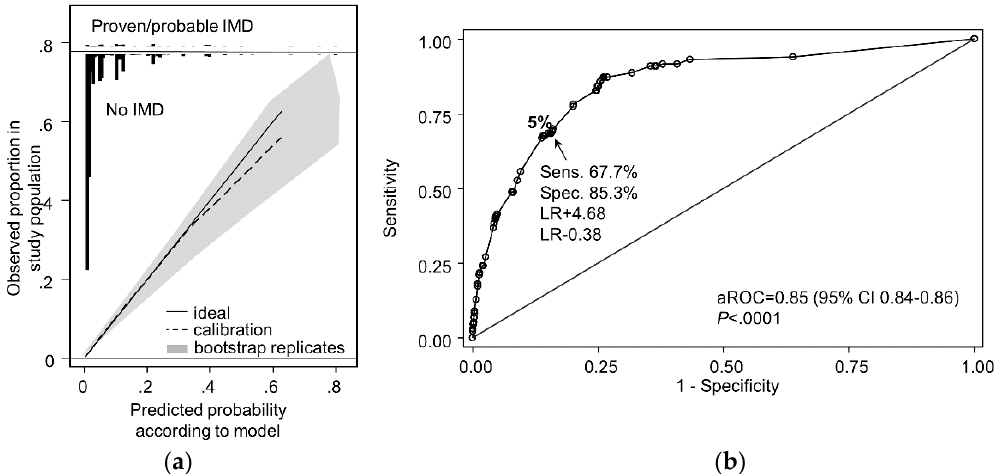
Figure 4. Revised BOSCORE model calibration and discrimination. Panel ( a ) shows the relationship between a perfectly calibrated model (solid line) and the observed incidence of EORTC/MSG proven, or probable mold disease fitted using the Loess smoothing algorithm (dashed line). Black bars on the top frame of the graph show the relative risk distribution of admissions without IMD (downward pointing spikes) or patients with proven or probable IMD (upward pointing spikes). The gray shaded area shows observed versus predicted incidence of proven or probable mold disease in 100 bootstrapped resampled datasets with varying IMD incidence of 2–9%. Panel ( b ) shows the area under the receiver operator curve (aROC) and predicted performance for EORTC/MSG probable or proven IMD at a prediction cut-off of 5%. Sens., sensitivity, spec. specificity, LR, likelihood ratio.